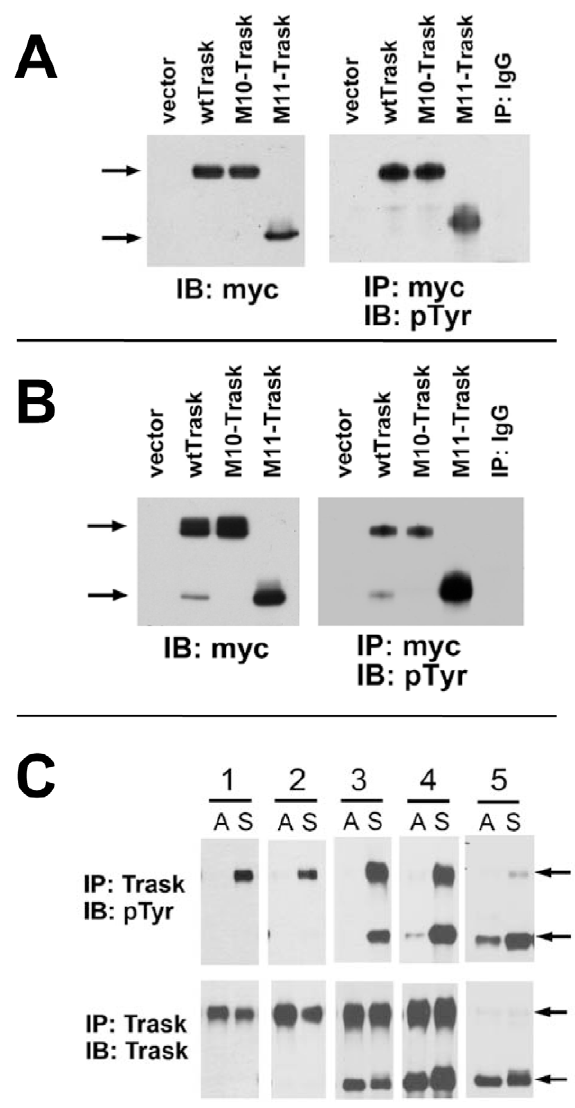
Figure 6. Trask cleavage and phosphorylation. A,B ) HEK293 (A) or MDA-468 (B) cells were transiently transfected with the indicated mutant constructs or wildtype or vector controls and total cell lysates were assayed as indicated. These blots are representative of multiple experiments (shown in Figure S4). C ) Cell lysates from five cell lines were harvested while adherent (A) or after 2 hours of culture in suspension (S) and immunoblotted as indicated. Lanes correspond to 1) L3.3 cells, 2) SW480 cells, 3) DLD1 cells, 4) PC3 cells, and 5) MDA-468 cells. Arrows indicate the larger uncleaved and smaller cleaved forms of Trask. These blots are representative of two experiments. The MDA-468 blot is representative of . 5 independent experiments.